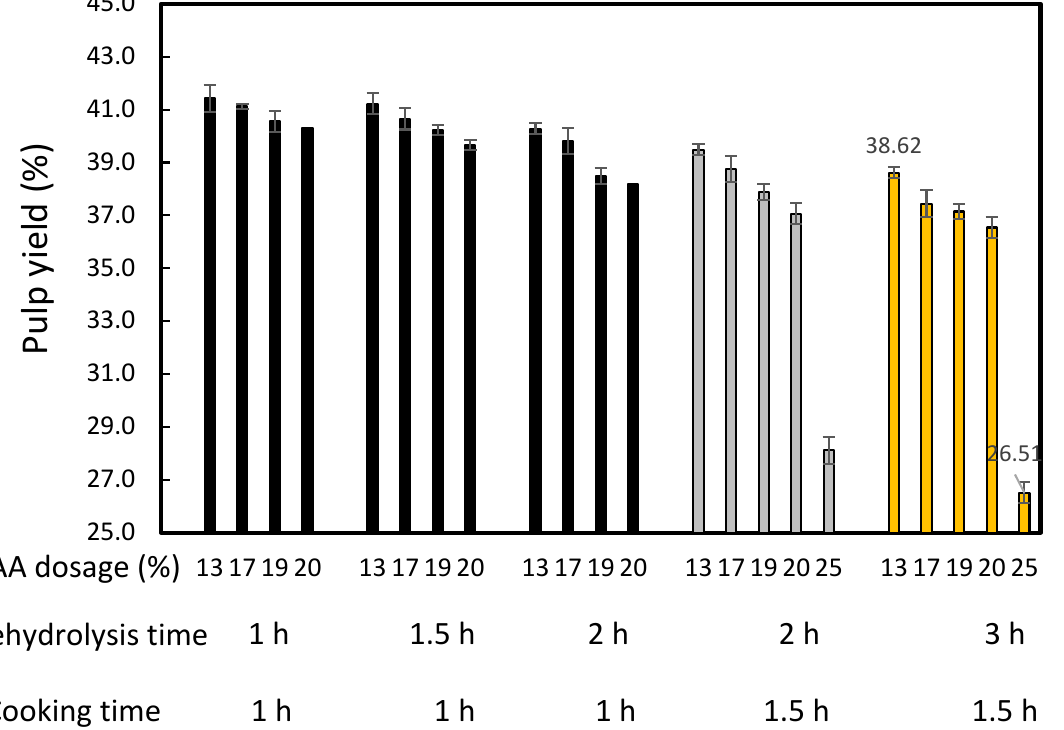
Figure 3. Effect of prehydrolysis time on the pulp yield of Nypa fruticans frond soda-SAQ pulp. The values presented are averages ± standard deviations.